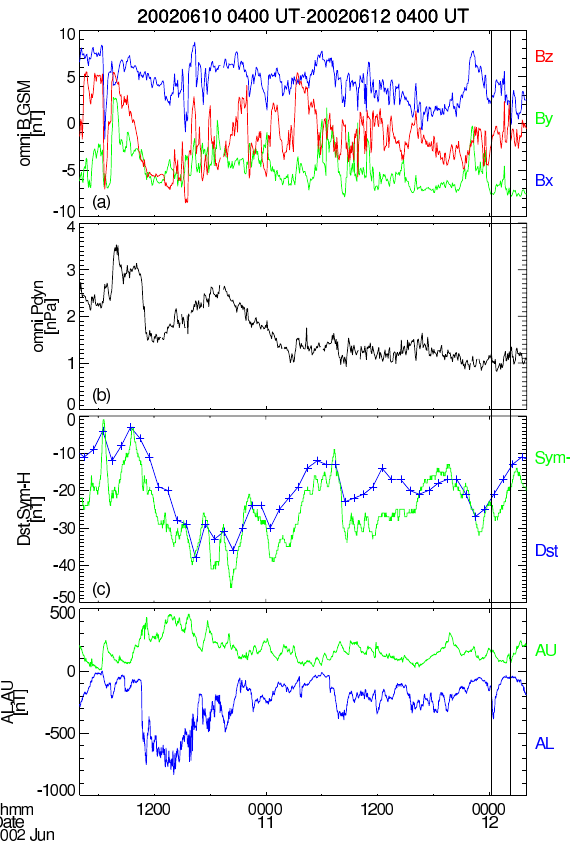
Fig. 1. Interplanetary and geomagnetic parameters from 04:00UT on 10 June 2002 to 04:00UT on 12 June 2002. From top to bot- tom: (a) The three components of IMF (interplanetary magnetic field) in GSM (geocentric solar-magnetospheric) coordinates from OMNI database, (b) the solar wind dynamic pressure from OMNI database, (c) Dst and SYM-H indices, and (d) AU and AL indices. Two vertical lines bracket the interval within which Cluster ob- served